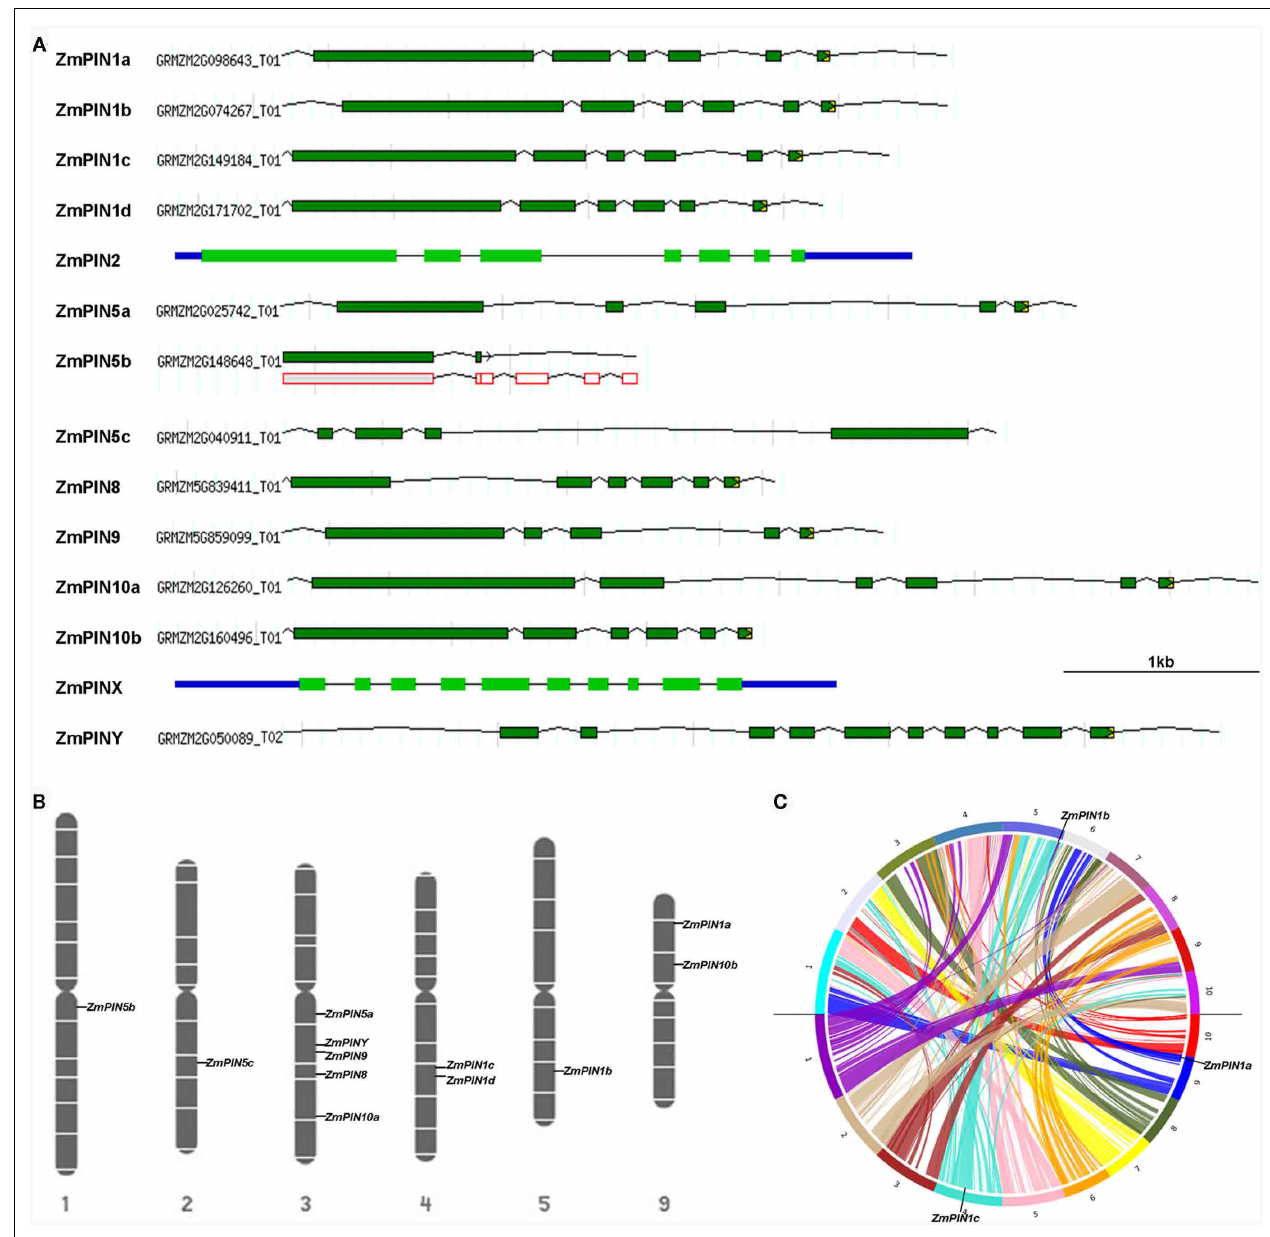
representation of maize chromosomes showing the location of ZmPIN loci identified by searching the www.maizesequence.org database.The exact physical position is instead reported inTable S3 in Supplementary Material. (C) Circular representation of the 10 maize chromosomes showing duplicated blocks. ZmPIN1a , ZmPIN1b , and ZmPIN1c position in duplicated region has been displayed with Synteny Mapping and Analysis Program (SyMAP) v3.4 (Soderlund et al., 2011;